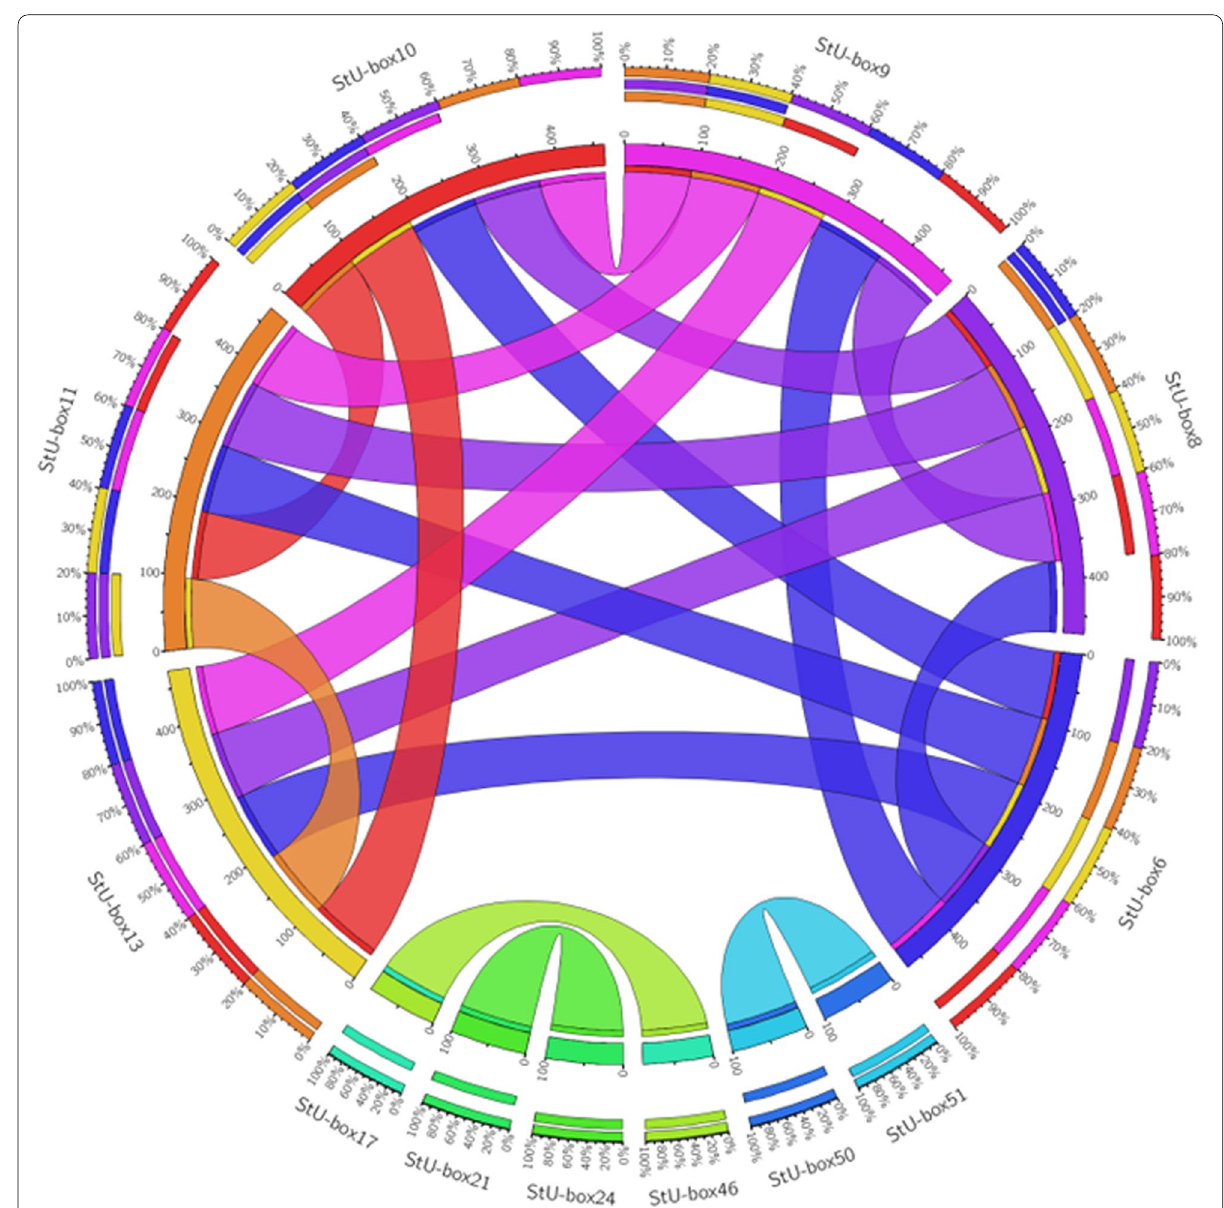
Fig. 7 Synteny analysis of StU-box genes. Duplicated StU - box gene pairs (paralogous) relationship of U - box genes as visualized by online